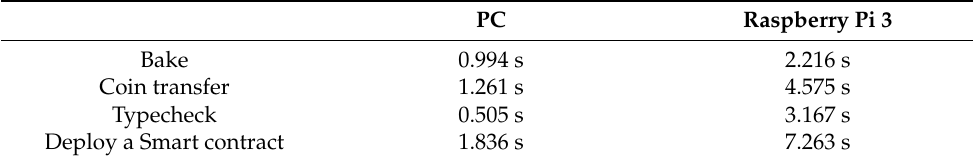
Table 2. Tezos basic operations execution time.